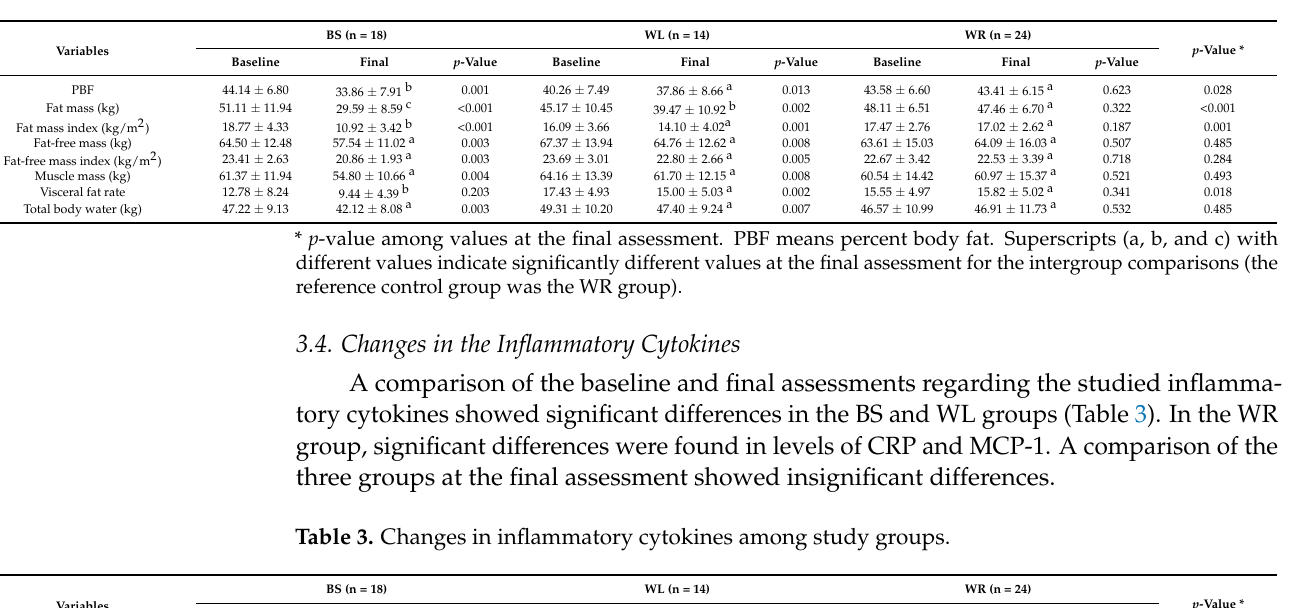
Table 2. Changes in body composition among study groups.